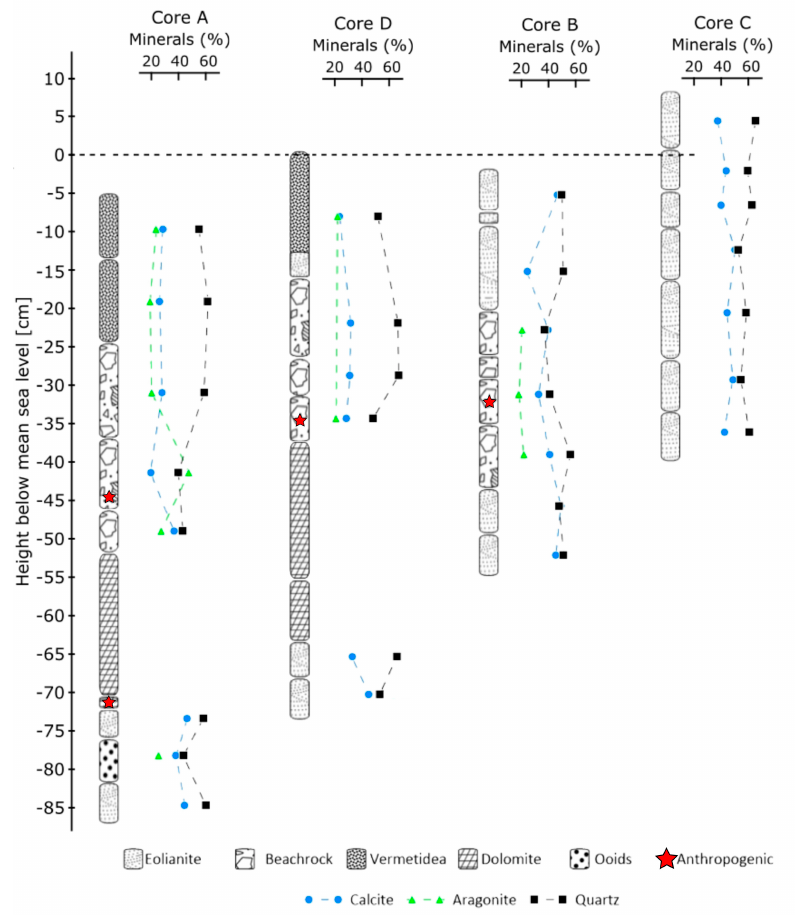
Figure 2. The lithological sequence of all cores and their major mineralogical components. See Figure 1b for locations. The cores are divided into the separate segments described in the Results. Y-axis denotes height relative to present-day mean sea level. Please note that the top of core A and B are below mean sea level, i.e., the top of the platform that was cored was slightly under the surface of the water, and that Cores A and D appear next to each other for convenience of comparison.